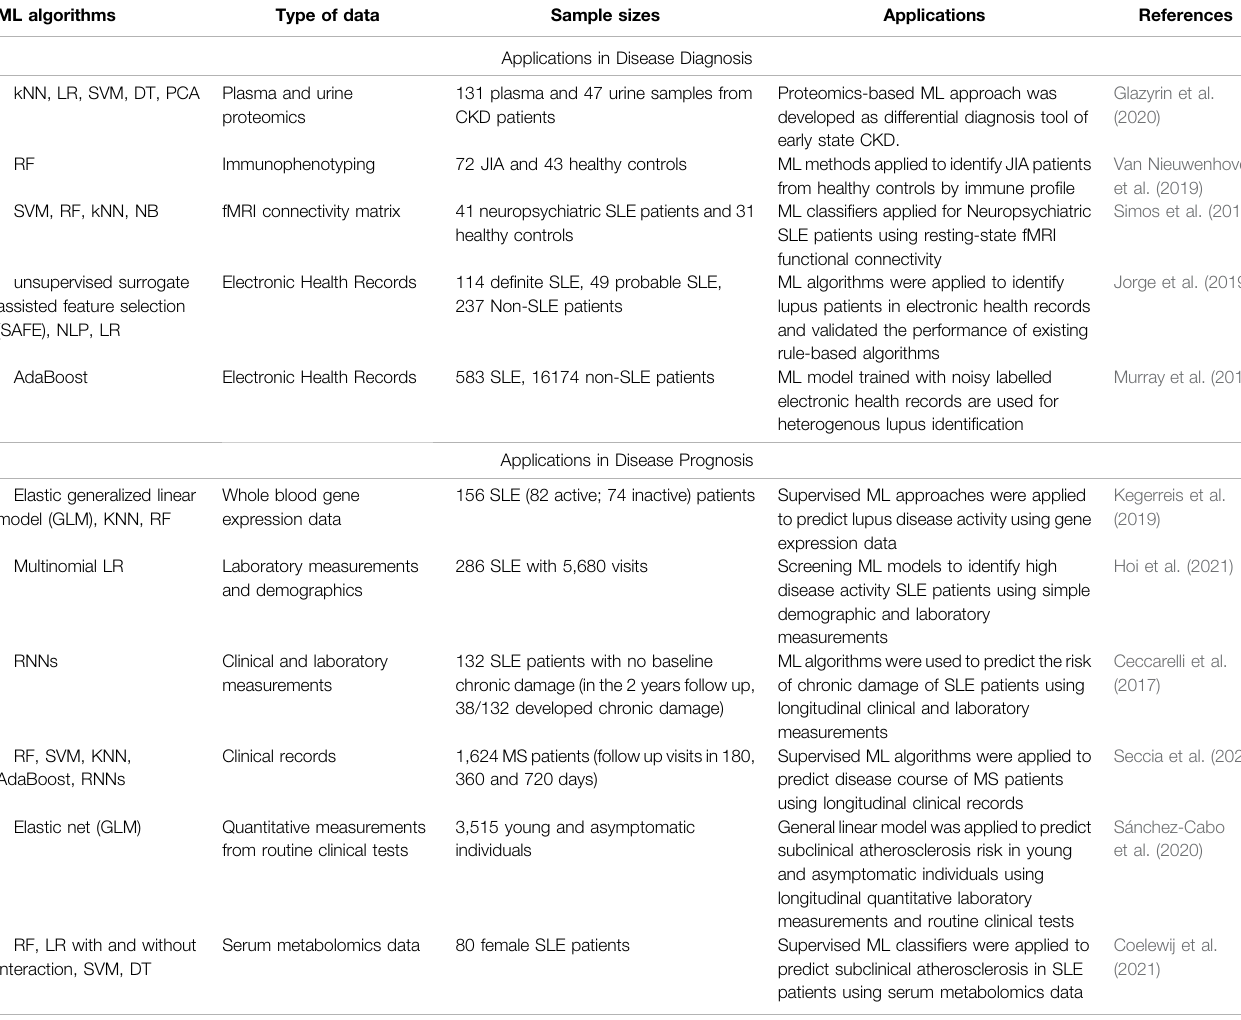
TABLE 1 | Examples of machine learning application in precision diagnosis and prognosis of in fl ammatory diseases. ML